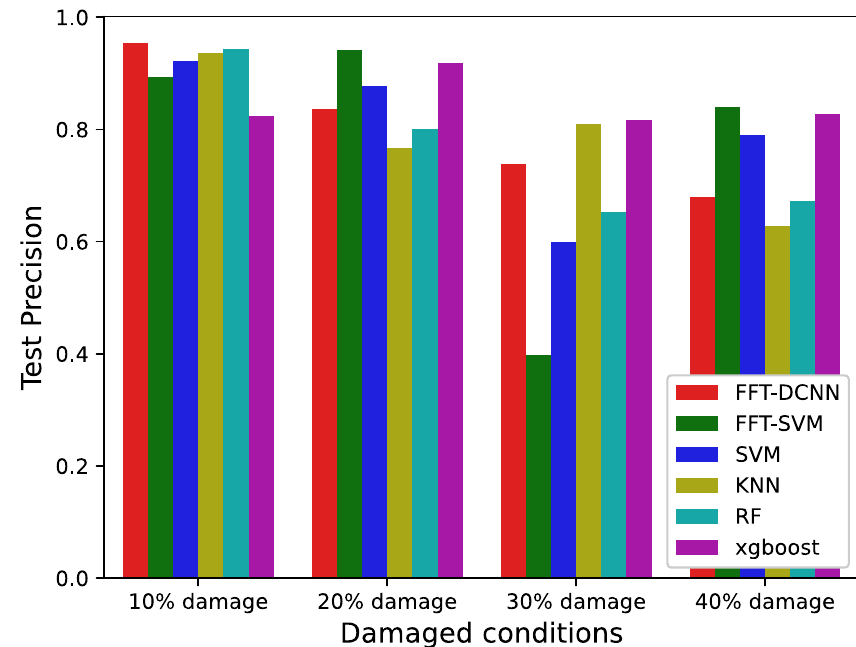
Figure 10. Precision of the test data using different algorithms.